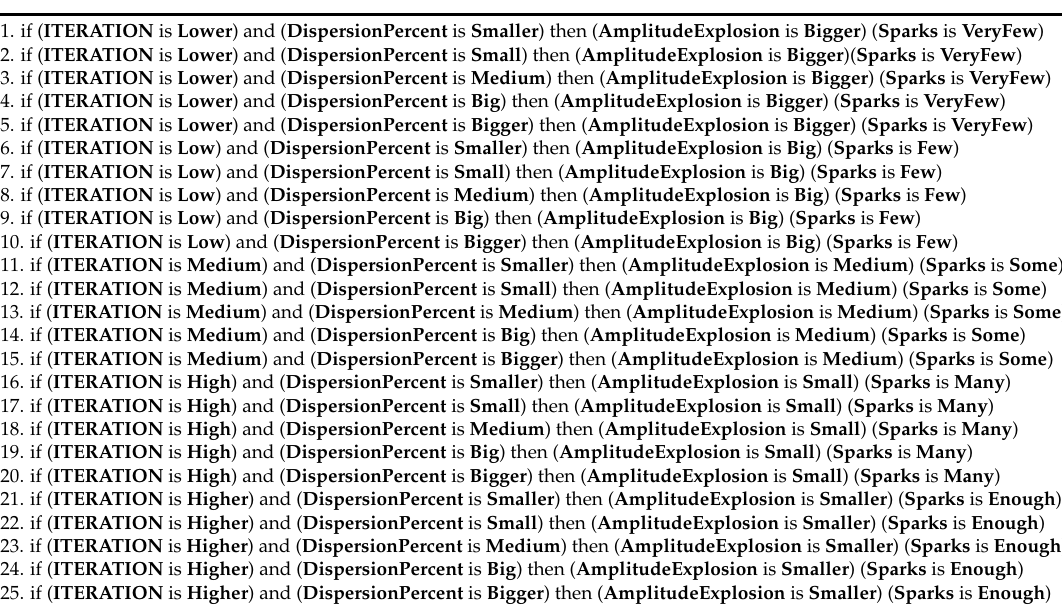
Table 2. Fuzzy rules of DPIFFWA-II.